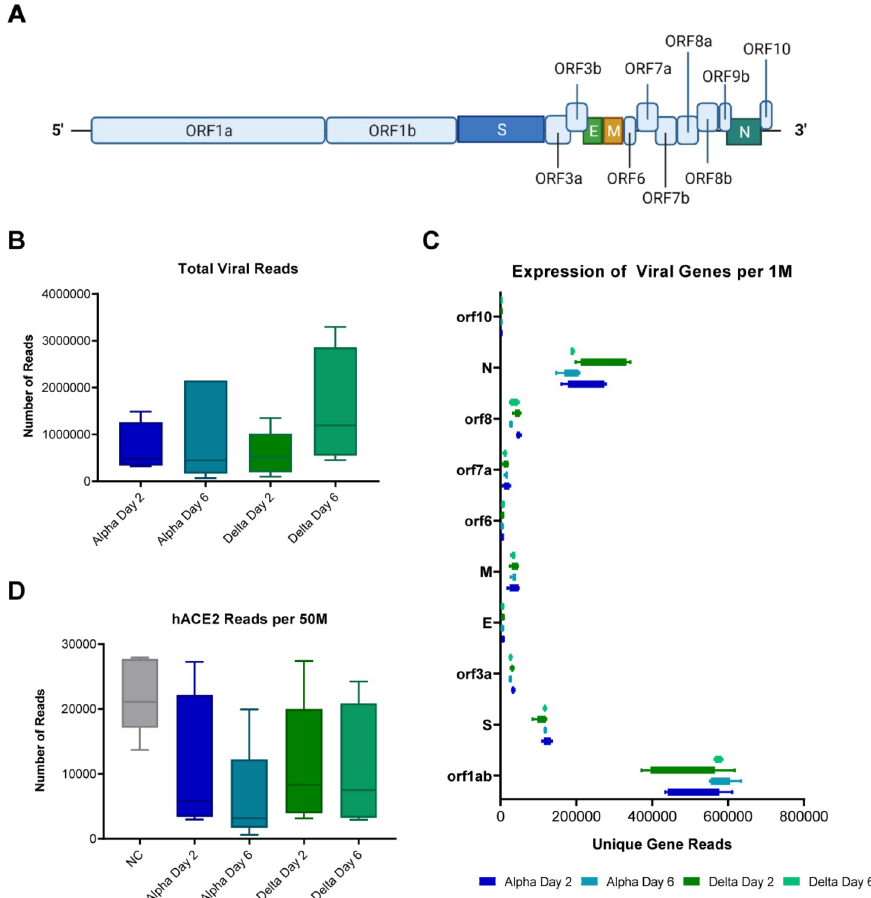
Fig 5. RNAseq analysis of SARS-CoV-2 genes in challenged mouse lungs. Schematic of the SARS-CoV-2 genome (A). Total viral read counts in each group (B) as well as quantification of viral reads per 1M RNAseq reads obtained (C). Reads of human ACE2 gene of the K18-hACE2-mice were quantified per 50M reads obtained per lung sample (D). (n = 4 in Alpha Day 2 and Delta Day 6; n = 5 in Alpha Day 6 and Delta Day 2).